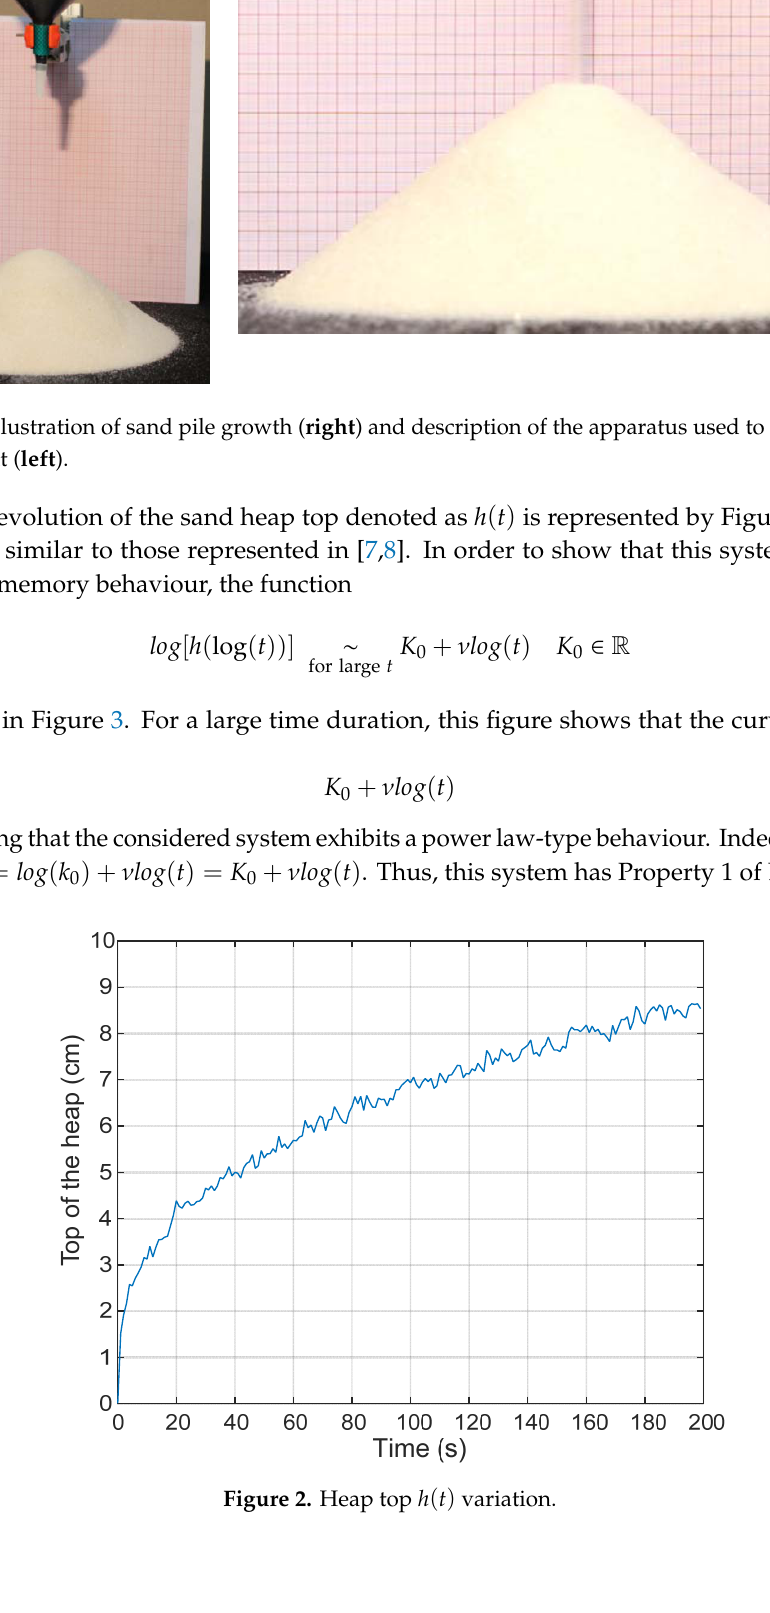
Figure 3. Function 𝑙𝑜𝑔(cid:4670)ℎ(cid:4666)log (cid:4666)𝑡(cid:4667)(cid:4667)(cid:4671).